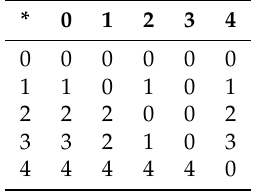
Table 6. Cayley table for the binary operation